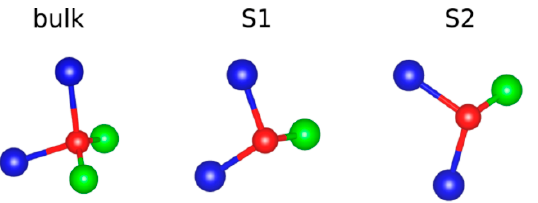
Figure 2. Local structure for the O vacant site in the bulk and on the surfaces. The Lu, Al, and O atoms are shown in blue, green, and red. Table 2. The calculated structure and Bader charge state of O atom in the bulk and surface.